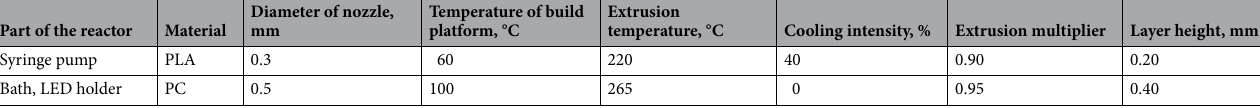
Table 1. Main parameters of FFF additive manufacturing for PLA and PC